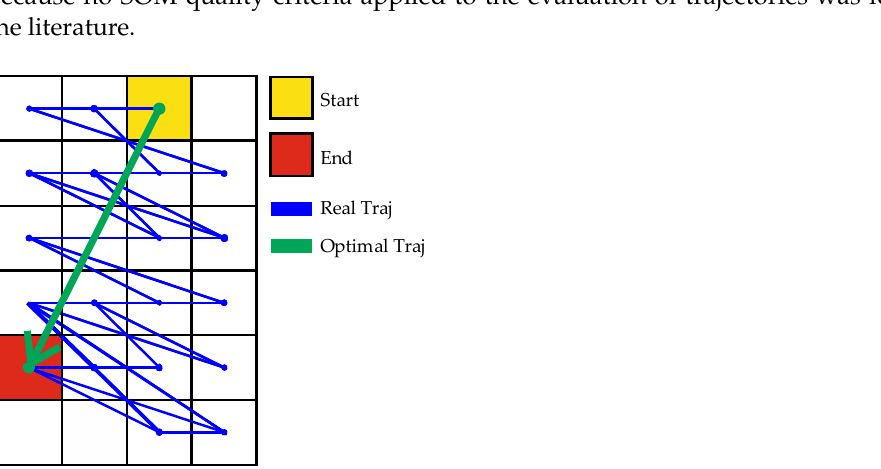
Figure 8. Two cell trajectories on the SOM for illustrating the relative deployment index DI ; DI ≈ 1.0 for the green trajectory (optimal, good deployment), DI >> 1 for the blue one (bad deployment).